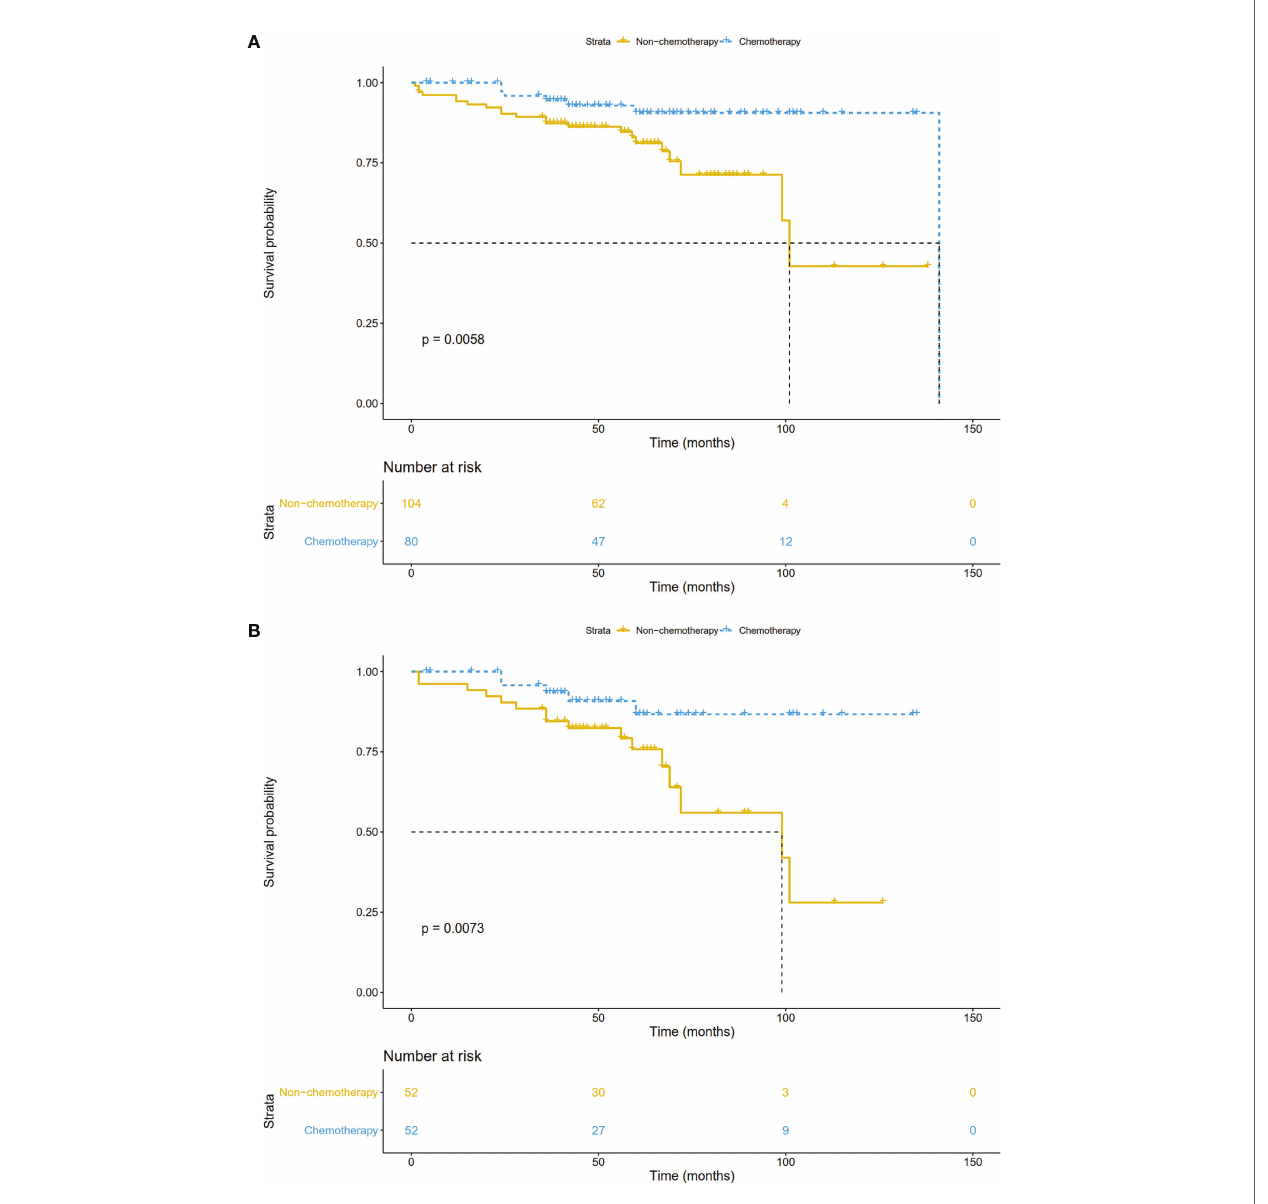
FIGURE 7 | Overall survival comparisons by treatment arm for stage IB NSCLC patients in the validation cohort (A) before PSM and (B) after